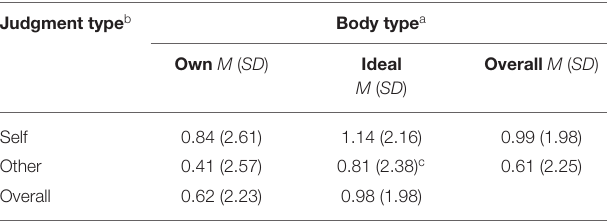
TABLE 2 | Mean BMI misperception scores for both own and ideal bodies, made during the figure rating scale (self) or the general estimation task